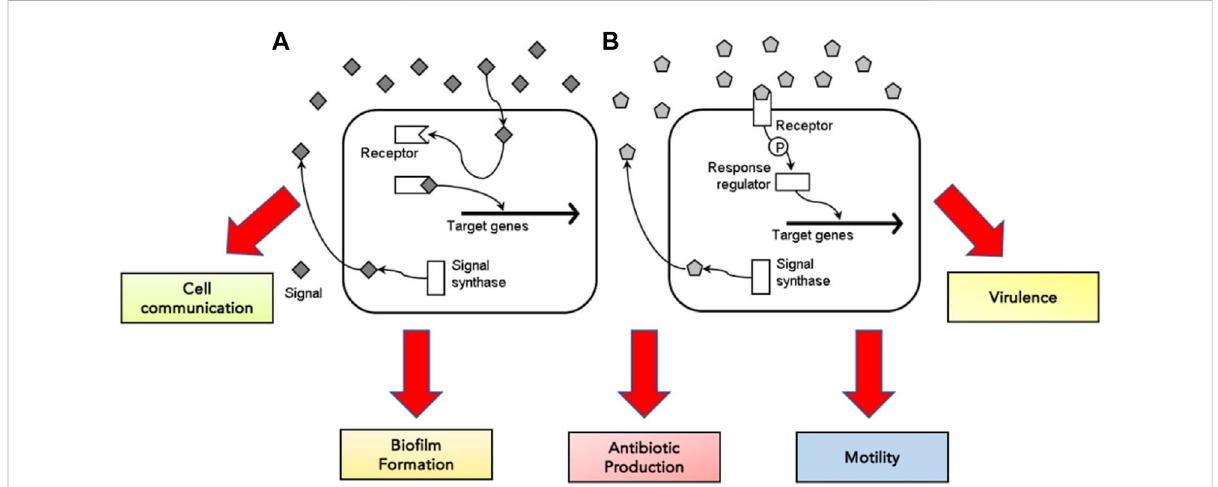
FIGURE 3 The concentration of signal molecules produced by the enzyme signal synthase is consistently monitored by bacterial cells in the surrounding environment. Whensignal molecules are low inconcentration,thesignal molecule binds to thetarget receptor, either inthecytoplasm (A) oron the cell surface (B) — adapted from Defoirdt et al.